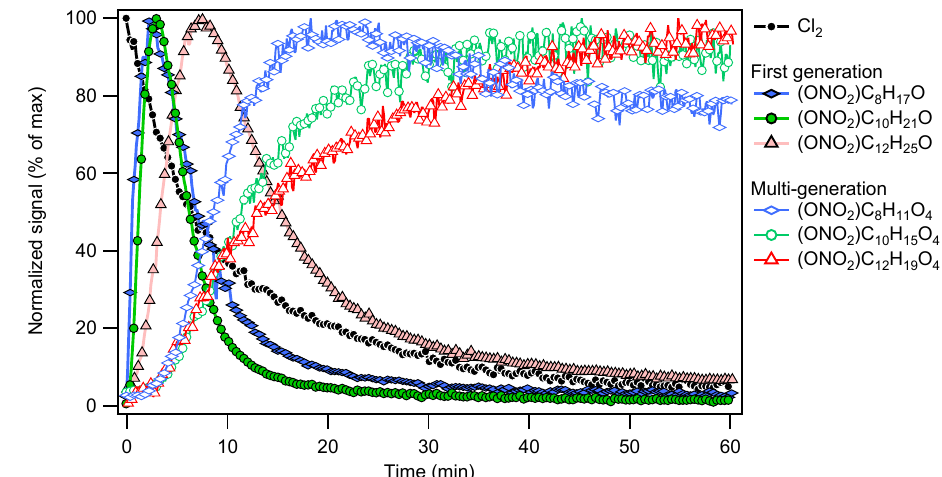
Figure 3. Trends of early-generation gas-phase oxidation products (hydroxynitrates) and multigeneration-oxidation products (hydroxycar- bonyl nitrates) observed during chlorine-initiated oxidation of octane (Exp. 3), decane (Exp. 7), and dodecane (Exp. 11). Species shown were first normalized against the I − reagent ion signal and then normalized against their respective